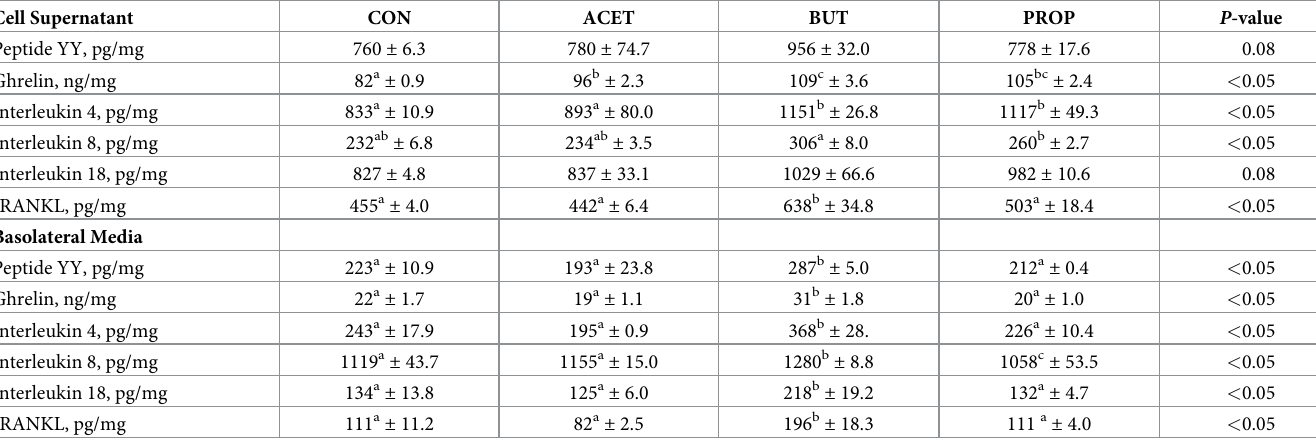
Table 1. Protein expression of neuroendocrine hormones and cytokines in human 2D duodenal enteroids treated with short chain fatty